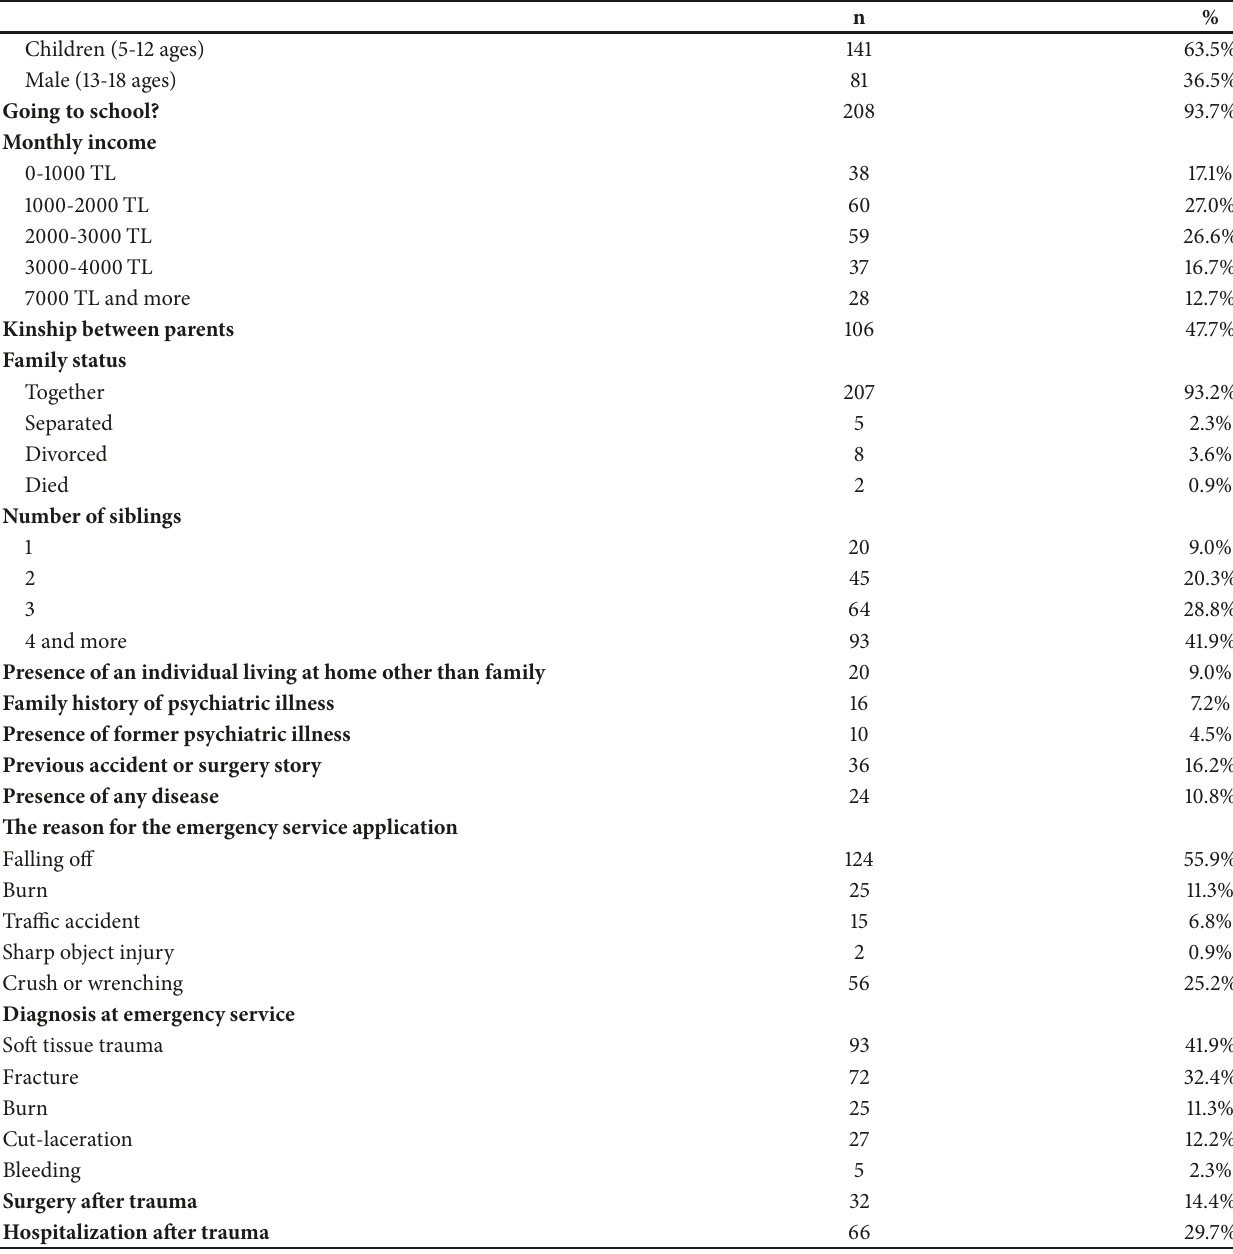
Table 1: Sociodemographic variables and accident/injury